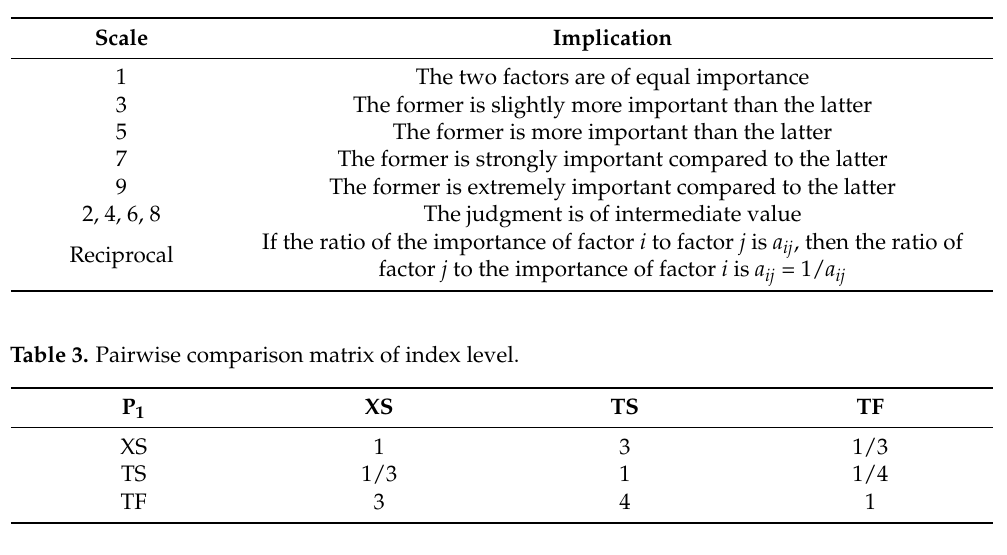
Table 2. Judgment matrix scale definition.